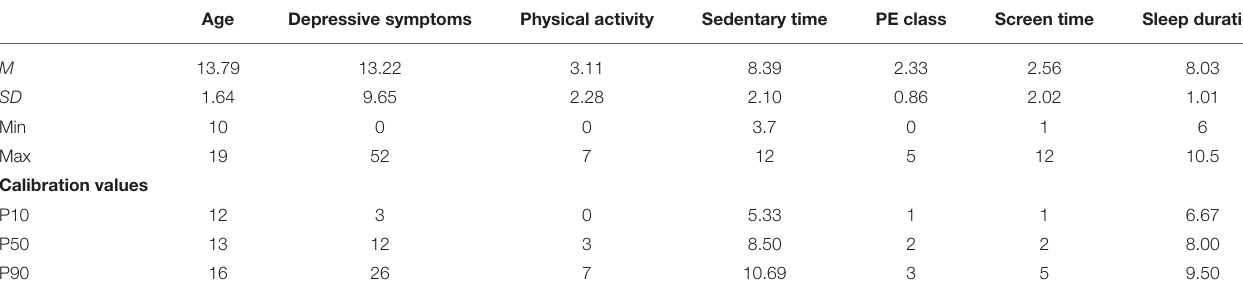
TABLE 1 | Main descriptions and calibration